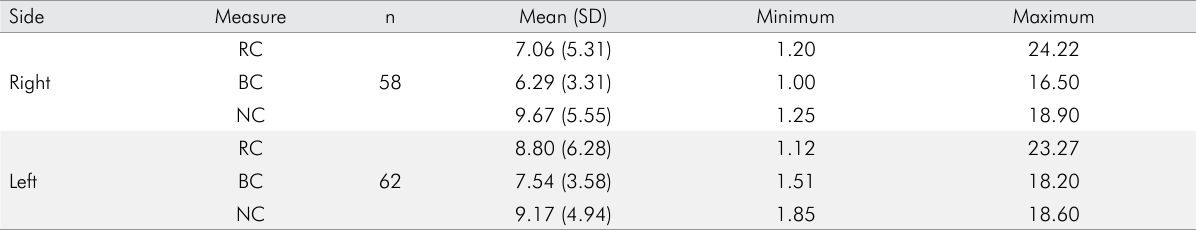
Table 2. Statistical data of the comparisons between the sides of measures RC, BC and NC for female subjects.